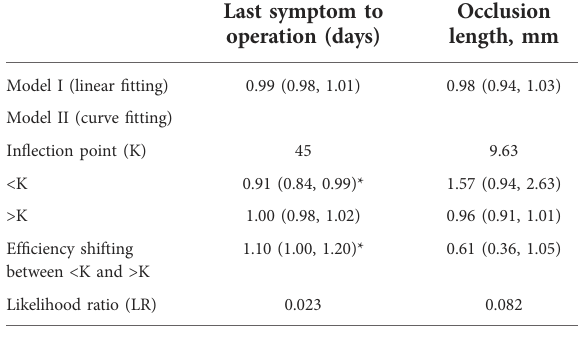
TABLE 4 Threshold effect analysis of related factors of successful